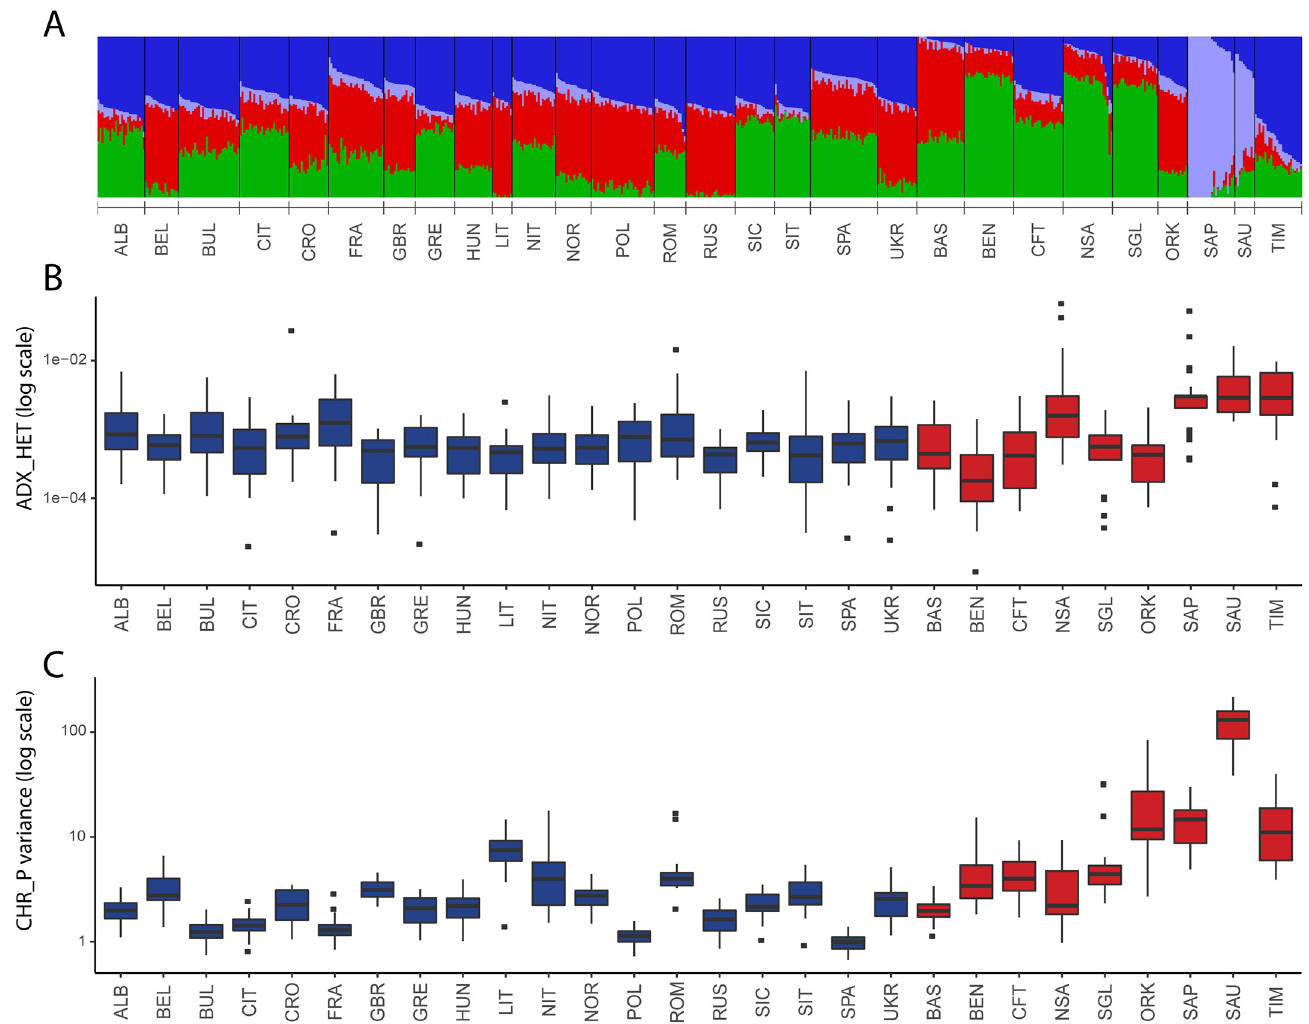
Fig 3. Inter-individual heterogeneity of ancestry components and intra-population haplotype sharing. (A) Maximum likelihood estimates of individual ancestries (K = 4) for the 28 populations under study; (B) intra-population distribution of the admixture heterogeneity measure (y axis log scale); (C) Inter- individual heterogeneities of the total length of chunks among individuals in each population (y axis log scale; see Materials and methods for more detail).